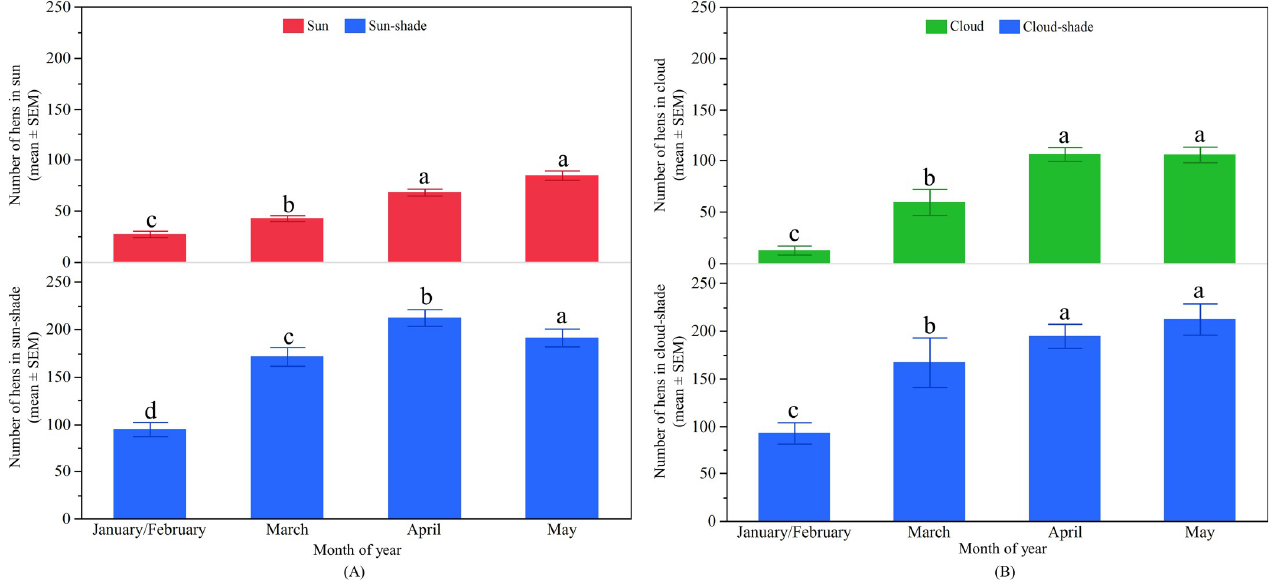
Fig 9. Distribution of hens on the range across months in WA: (A) The mean ( ± SEM) number of hens in the ‘sun’ (top) and ‘sun-shade’ (bottom); (B) The mean ( ± SEM) number of hens in the ‘cloud’ (top) and ‘cloud-shade’ (bottom). a-d Dissimilar superscript letters indicate significant differences among months. Raw values are presented with analyses conducted on transformed